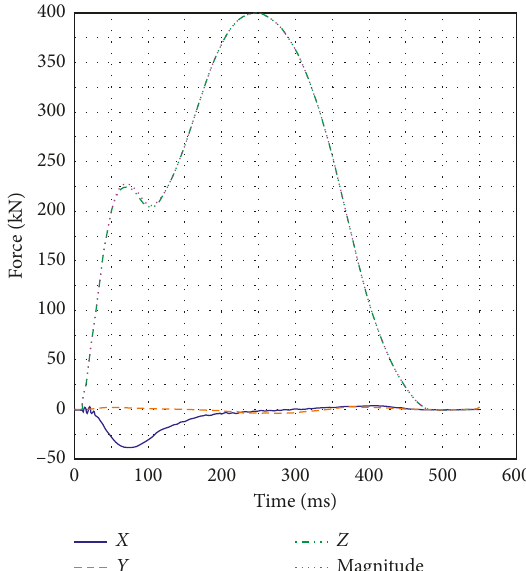
Figure 30: Contact force between tyre and rigid wall.